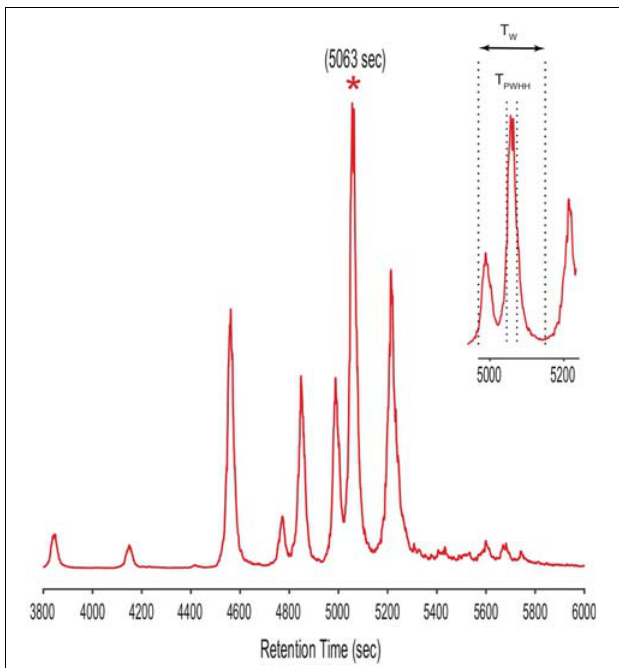
FIGURE 5 | LC-ICPMS Fe-chromatogram of the SPE organic extract of V. cyclitrophicus strain 1F-53 culture media after addition of iron. The starred peak (*) was selected as our unknown target metabolite to illustrate the application of CMAs. The insert shows the definition of the time window (T w ) in the CMAs, as determined by the retention time (T R = 5063s) and the peak width at half height (T PWHH ).